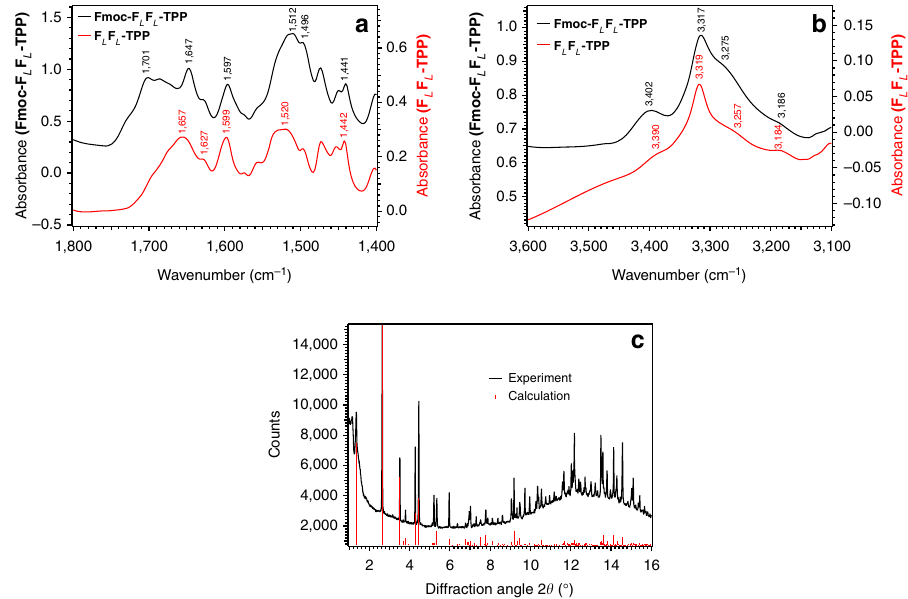
Figure 5 | FT-IR spectra and XRD powder diffraction of Fmoc-F L F L -TPP microcrystals. FT-IR spectra of F L F L -TPP dipeptide KBr pellets in the spectral region of ( a ) CO, CN, CC and ( b ) NH stretching vibrations. The black trace is from the Fmoc-protected TPP-F L F L dipeptide while the red trace is from the unprotected F L F L - TPP dipeptide. XRD powder pattern of the same Fmoc-F L F L -TPP microcrystals ( c ). The black trace is the experimental powder diffraction pattern ( l ¼ 1.0000Å). Red lines are the simulated reflections from the single-crystal data described below. A logarithmic scaling of the measured intensities as a function of 2 Y is presented in Supplementary Fig.